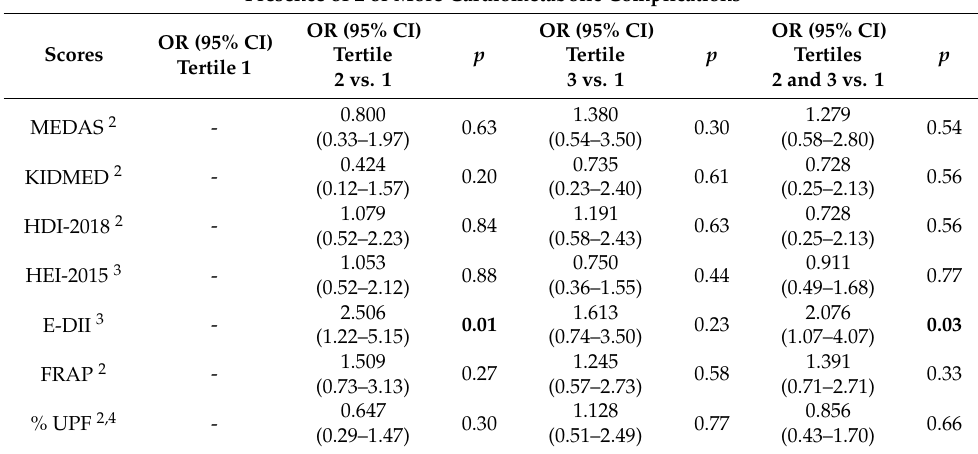
Table 5. Association between adherence to nutritional scores and having ≥ 2 cardiometabolic complications. Presence of 2 or More Cardiometabolic